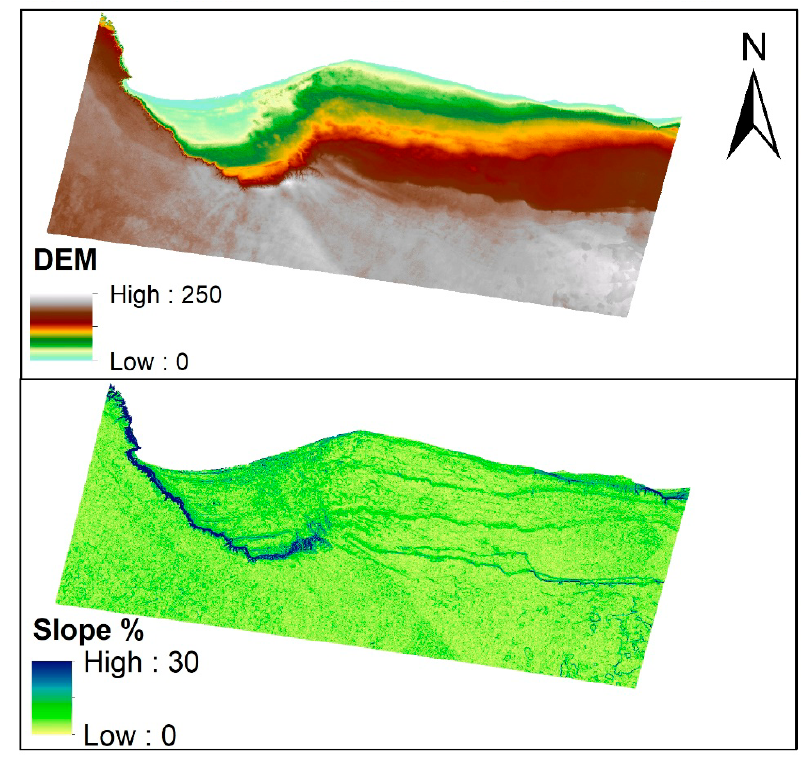
Figure 2. Digital elevation model (DEM) in meters and slope (%) of the study area.